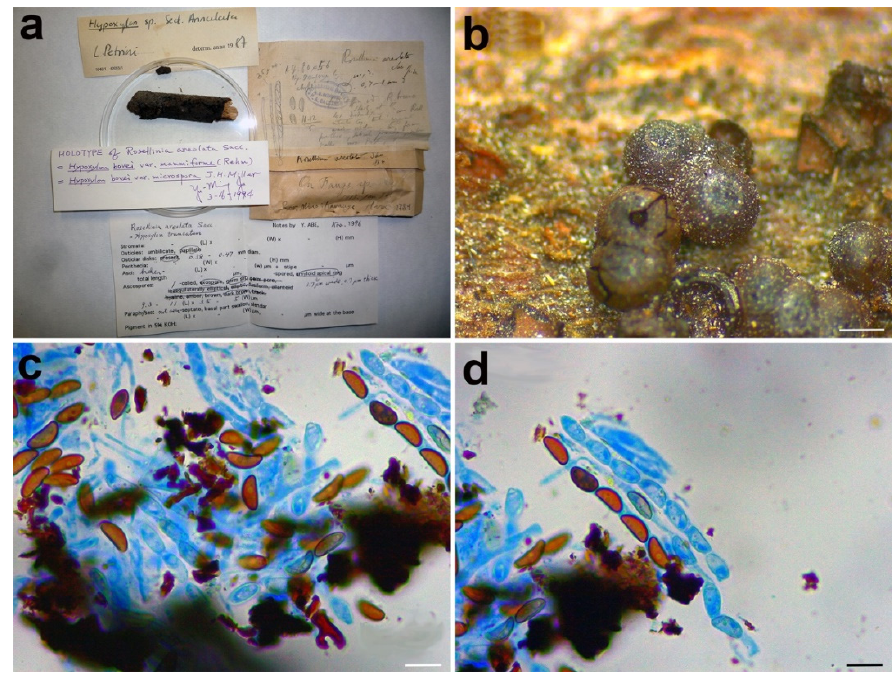
Figure 5. Rosellinia areolata . ( a ) Original fungarium specimen. ( b ) Perithecia on natural substrate. ( c , d ) Ascospores. Scale bars: ( b ) = 500 μ m; ( c , d ) = 10 μ m.